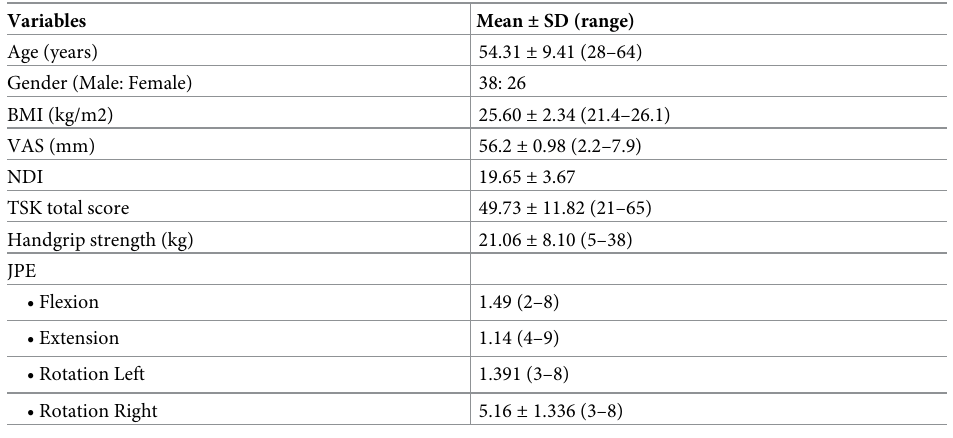
Table 1. Participant demographics, self-report measures, and study data ( n =